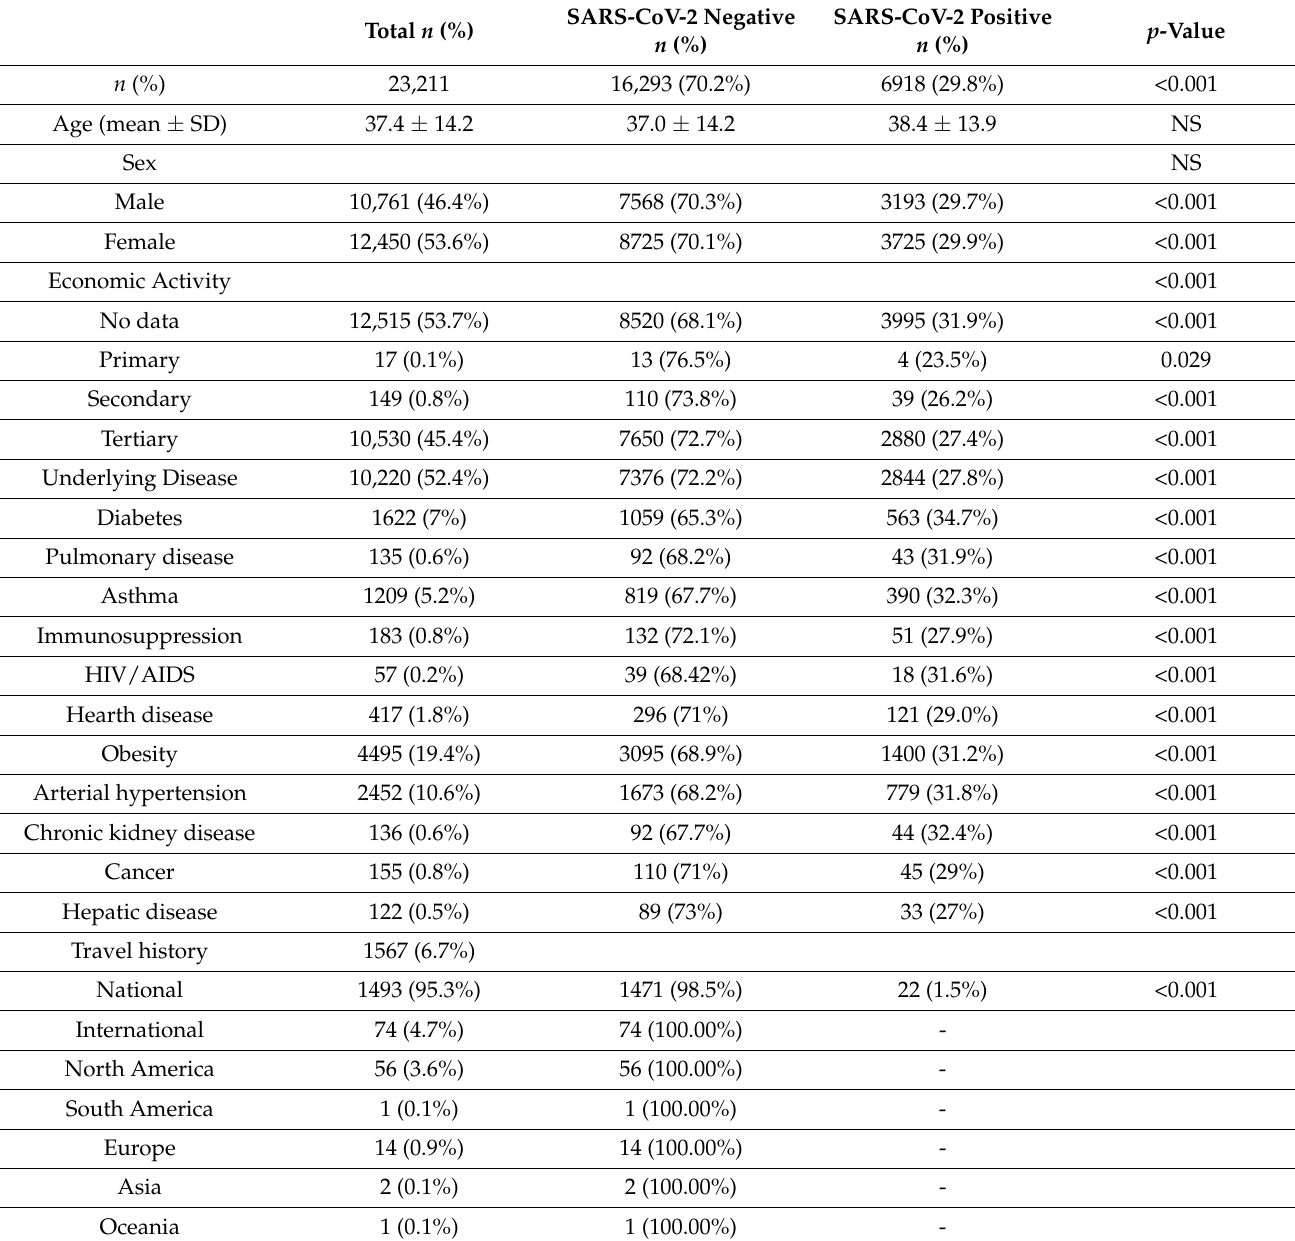
Table 1. Demographic, clinical, underlying diseases, and travel history from study population among April–December 2020.